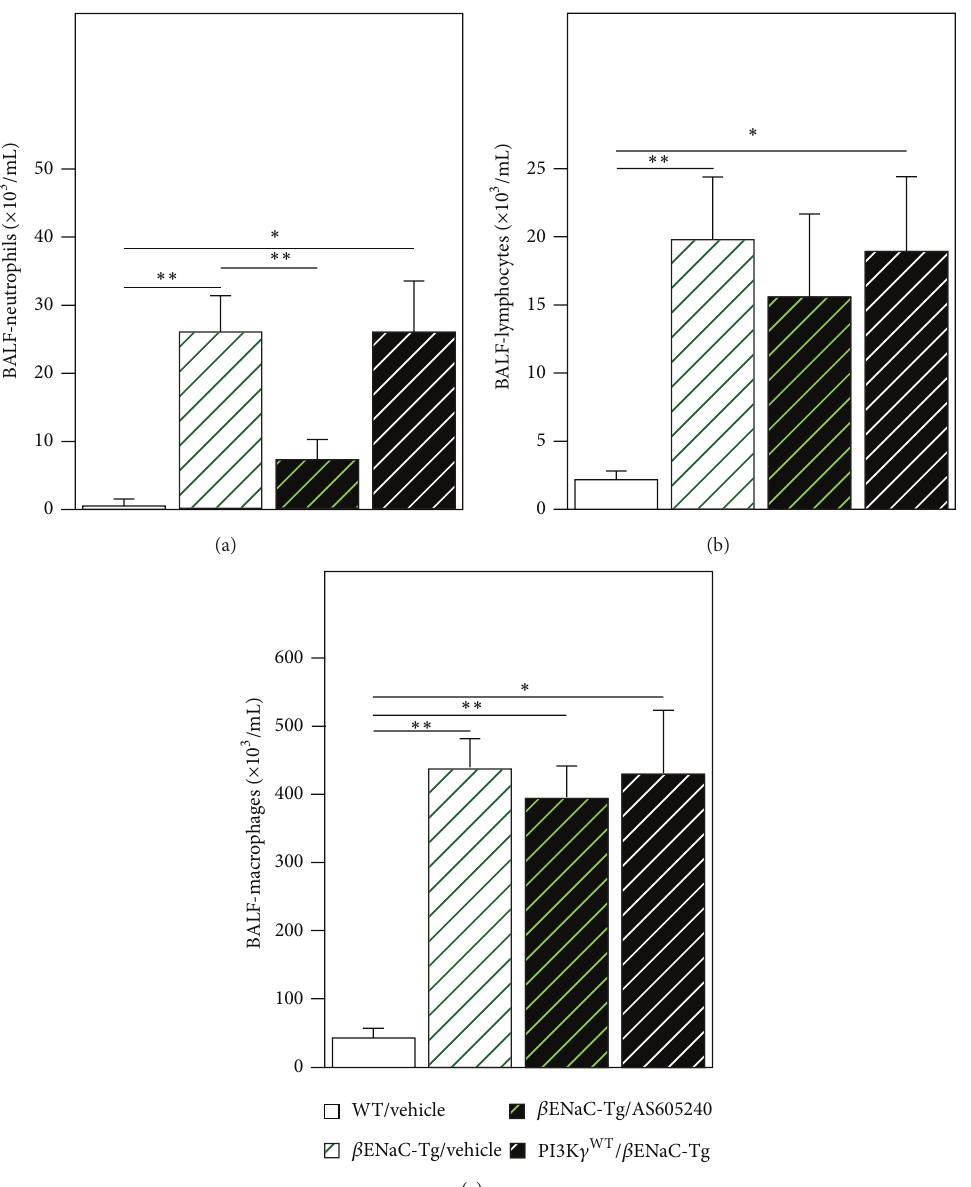
Figure 3: Pharmacological inhibition of PI3K 𝛾 decreases neutrophilic airway inflammation in 𝛽 ENaC-Tg mice . Neutrophils (a), lymphocytes (b), and macrophages (c) numbers were determined in BAL fluid of control (WT/Vehicle) and 𝛽 ENaC-Tg mice untreated or treated with the PI3K 𝛾 inhibitor AS-605240 ( 𝛽 ENaC-Tg/AS-605240) or with vehicle ( 𝛽 ENaC-Tg/Vehicle). Cells are expressed as number per mL of BAL fluid. (a) ∗∗ 𝑃 < 0.01 WT/Vehicle versus 𝛽 ENaC-Tg/Vehicle, ∗∗ 𝑃 < 0.01 𝛽 ENaC-Tg/Vehicle versus 𝛽 ENaC-Tg/AS-605240 and ∗ 𝑃 < 0.05 WT/Vehicle versus PI 3 K 𝛾 WT / 𝛽 ENaC-Tg. (b) ∗∗ 𝑃 < 0.01 WT/Vehicle versus 𝛽 ENaC-Tg/Vehicle and ∗ 𝑃 < 0.05 WT/Vehicle versus PI 3 K 𝛾 WT / 𝛽 ENaC-Tg. (c). ∗∗ 𝑃 < 0.01 WT/Vehicle versus 𝛽 ENaC-Tg/Vehicle, ∗∗ 𝑃 < 0.01 WT/Vehicle versus 𝛽 ENaC-Tg/AS-605240, and ∗ 𝑃 < 0.05 WT/Vehicle versus PI 3 K 𝛾 WT / 𝛽